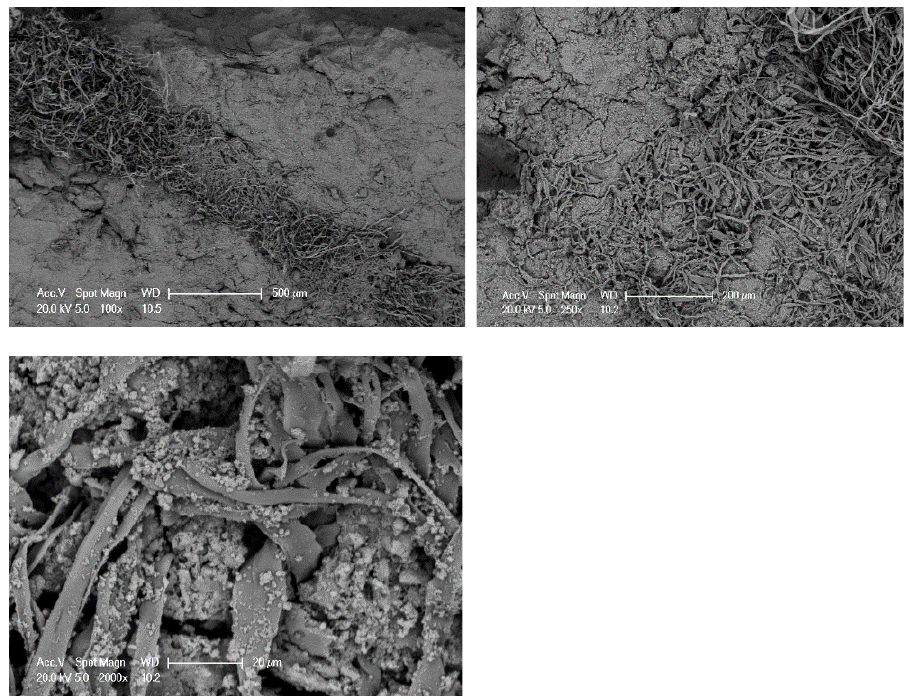
Figure 19. ITZ between cement paste and cut pieces of non-woven sheets.